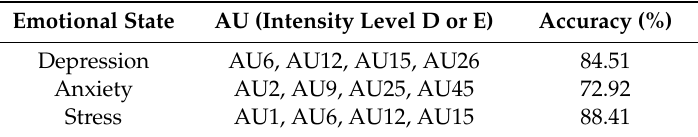
Table 3. Correlations between FACS and DASS levels.